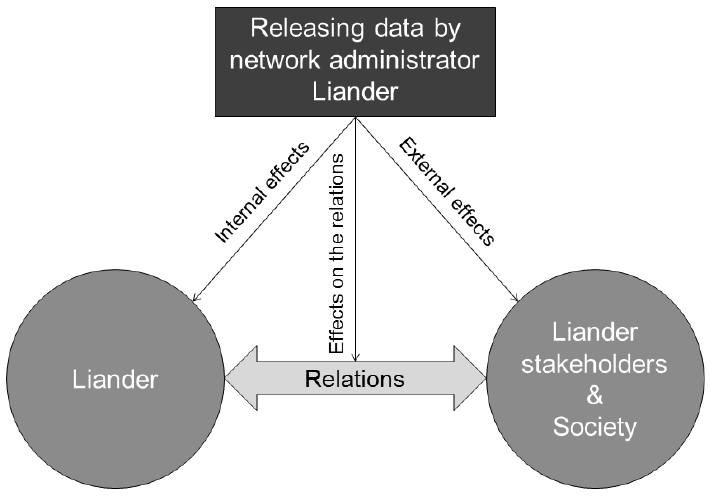
Figure 3. Effects of open data for Liander (after) [10].